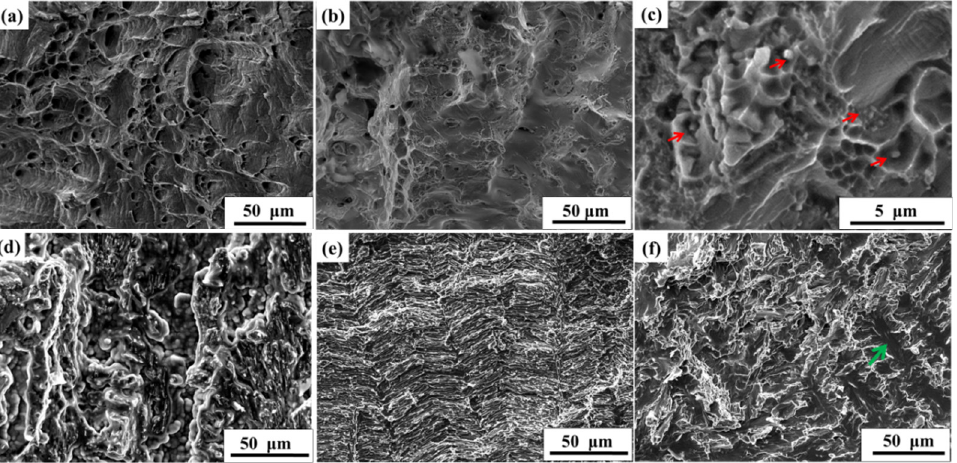
Figure 7. Fracture surface of (CoCuFeNi) 100- x Mo x alloys in tensile tests at room temperature: ( a ) x = 0; ( b ) x = 10; ( c ) a high-resolution image of ( b ); ( d ) x = 15; ( e ) x = 19; ( f ) x = 25.